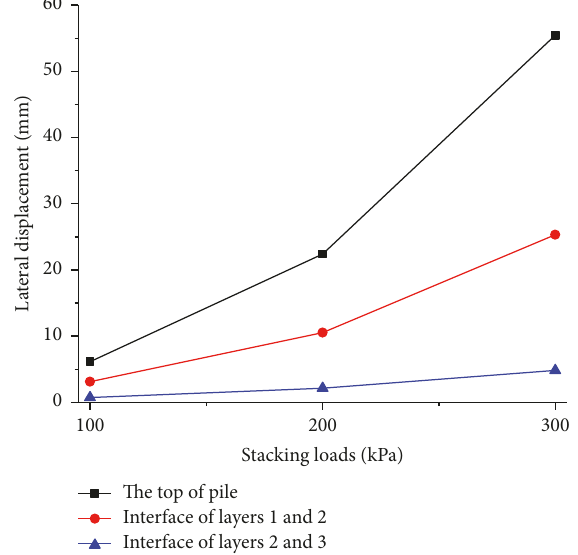
Figure 5: Relationship between lateral displacement and stacking loads at different positions.